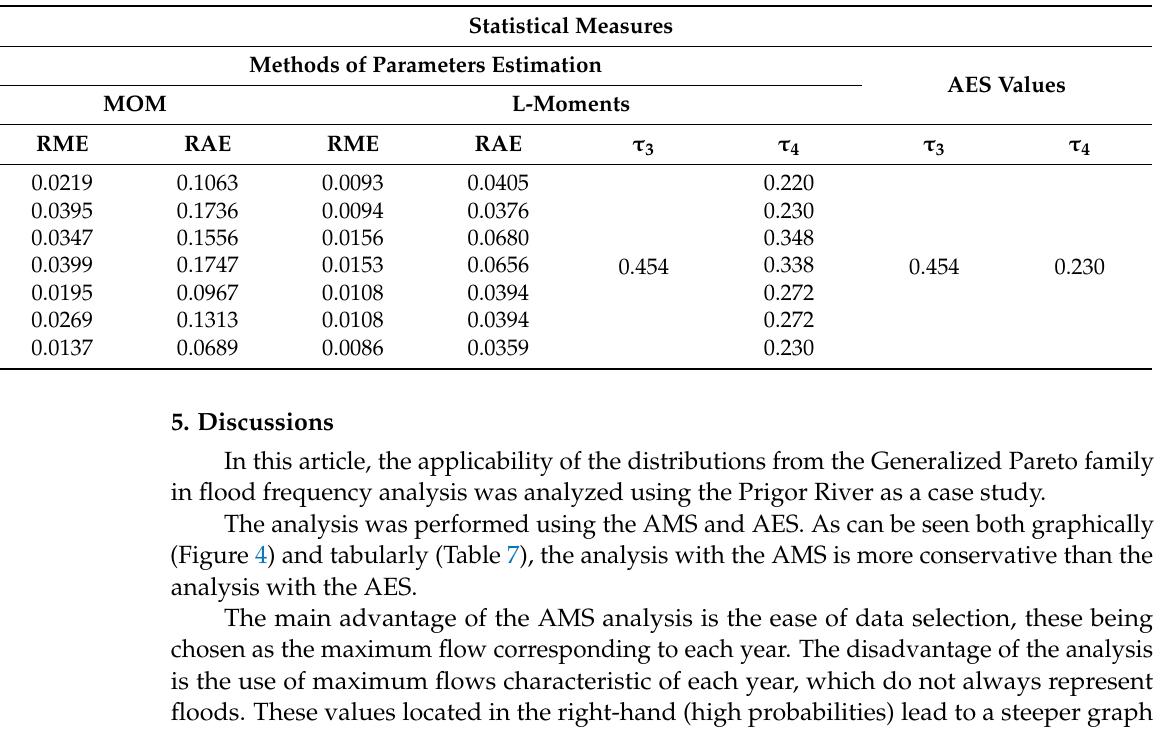
Table 11. Distribution performance values for